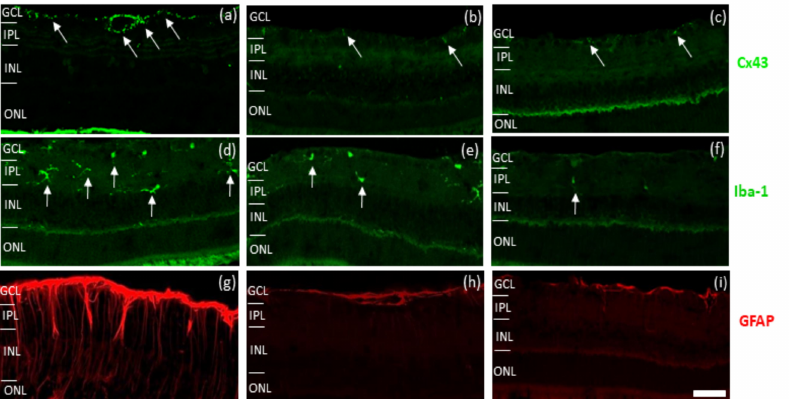
Figure 4. Effect of saline, probenecid and tonabersat combination and probenecid on immunoreactiv- ity of light-damaged rats. Light-induced damage increased expression of Cx43 (green) in the gan- glion cell layer ( a ). Probenecid and/or tonabersat treated rats showed less Cx43 immunoreactivity in the retina ( b , c ) compared to saline treated rats ( a ). Iba-1 immuno-labelled cells (green, highlighted by white arrows) were fewer in number in the retina of probenecid treated rats ( e ) and tonabersat and probenecid ( f ) compared to saline-treated rats ( d ). GFAP (red) immunoreactivity did not increase in the retina of probenecid treated rats ( h ) nor in the tonabersat and probenecid treatments ( i ) com- pared to saline-treated rats ( g ). Abbreviation: GCL, ganglion cell layer; IPL, inner plexiform layer; INL, inner nuclear layer; ONL, outer nuclear layer. Scale bar: 50 µ